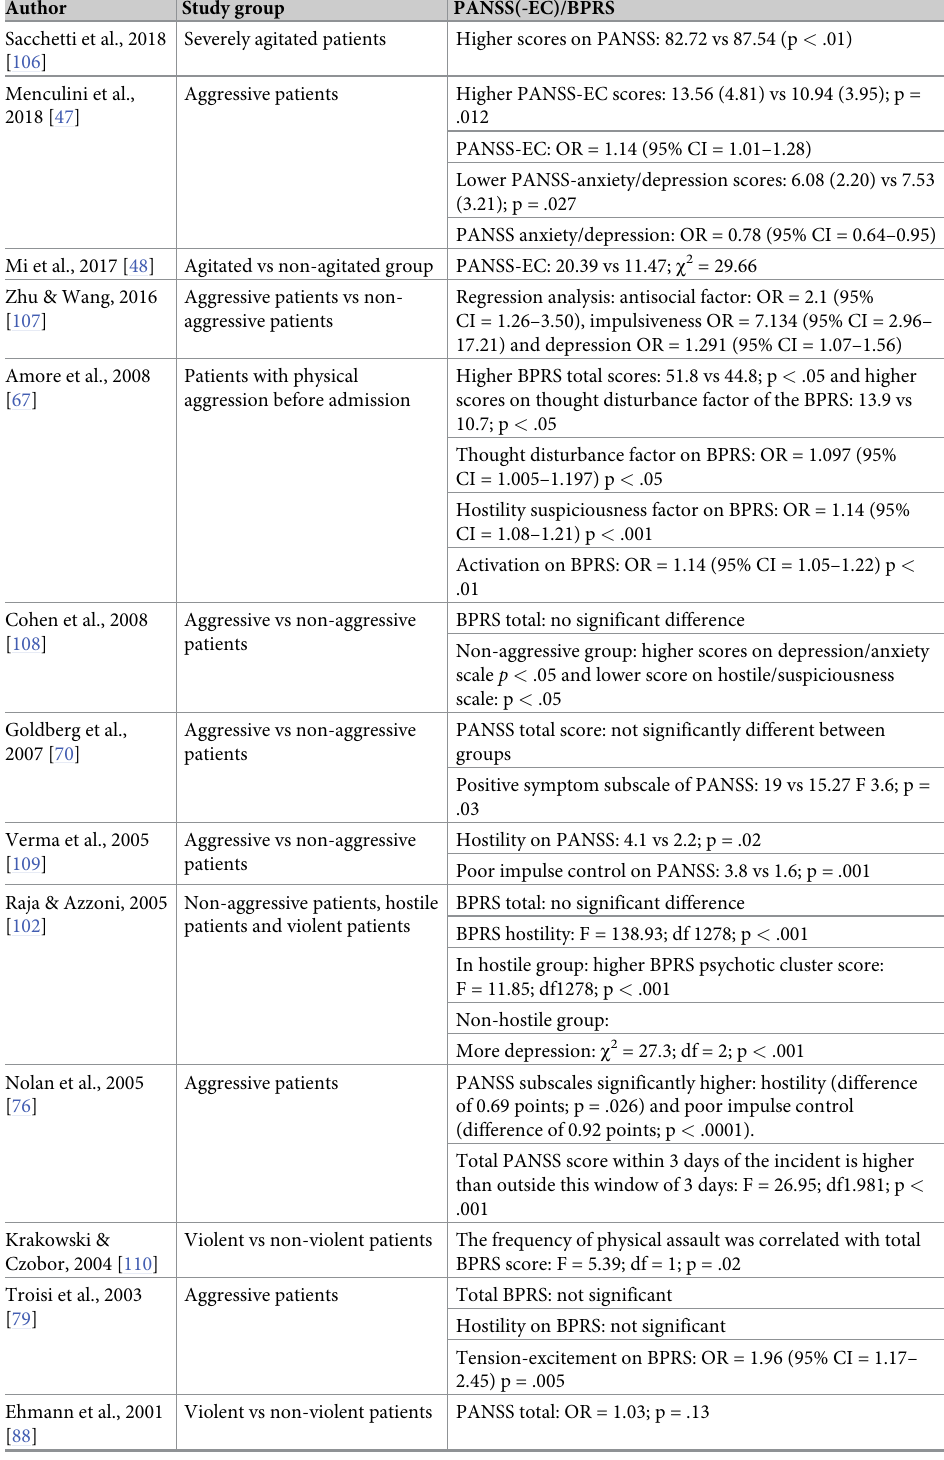
Table 2. Included studies with an association between PANSS(-EC)/ BPRS scores and the development of